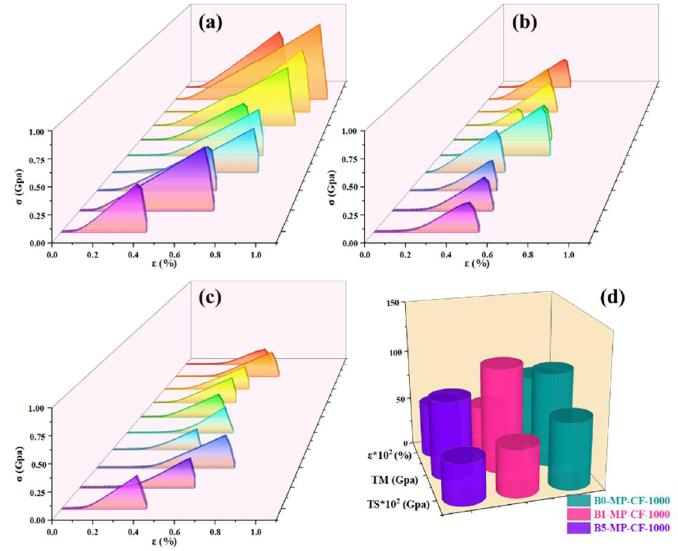
Figure 5. Stress − strain curves of B0 − MP − CF − 1000 ( a ), B1 − MP − CF − 1000 ( b ), B5 − MP − CF − 1000 Figure 5. Stress−strain curves of B0−MP−CF−1000 ( a ), B1−MP−CF−1000 ( b ), B5−MP−CF−1000 ( c ), ( c ), and their corresponding mechanical properties ( d ). and their corresponding mechanical properties ( d ).